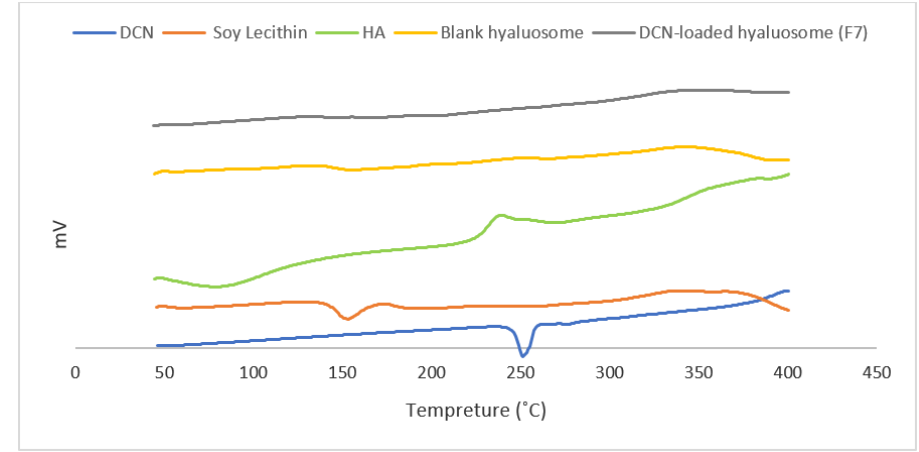
Figure 5. DSC thermograms for DCN, Soya lecithin, HA, and the optimized lyophilized DCN-loaded (F7) and blank hyaluosome